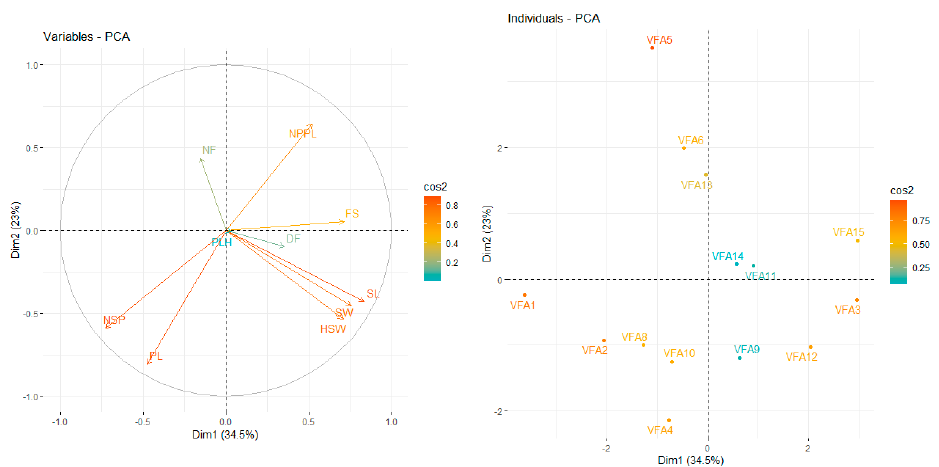
Figure 2. Principal component analysis (PCA) of fourteen Algerian faba bean accessions based on agro-morphological traits; DF, days to 50% flowering; FS, duration from sowing to fruit setting; NF, number of flowers per raceme; PLH, plant height; NPPL, number of pods per plant; PL, length of the pod; NSP, number of seeds per pod; SL, seed length; SW, seed width; HSW, 100-seeds weight.